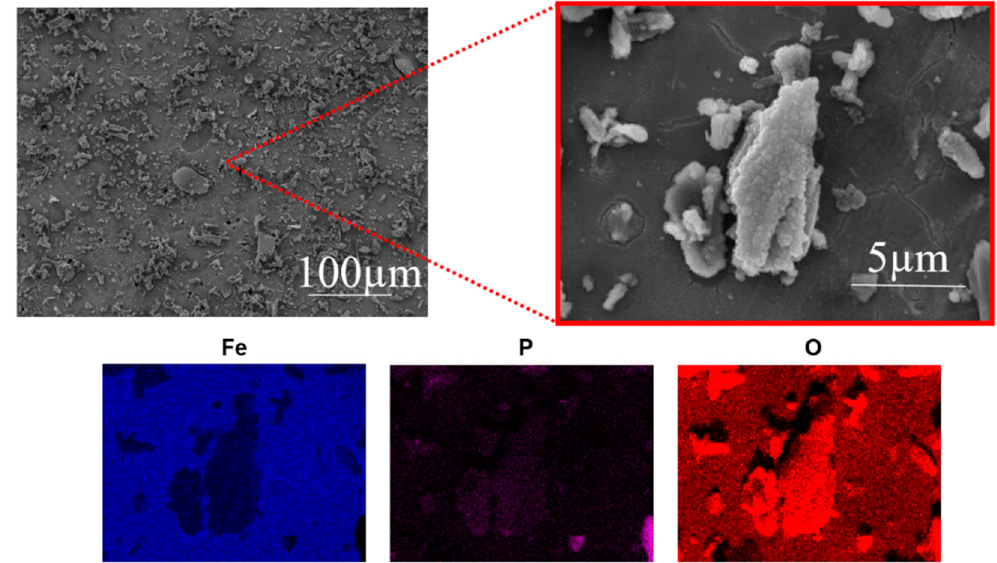
Figure 8. SEM image of S235 steel surface modified with ATP-6-AHA as the inhibitor after five days of immersion in 3.5% NaCl together with respective EDS maps Fe, P, and O.